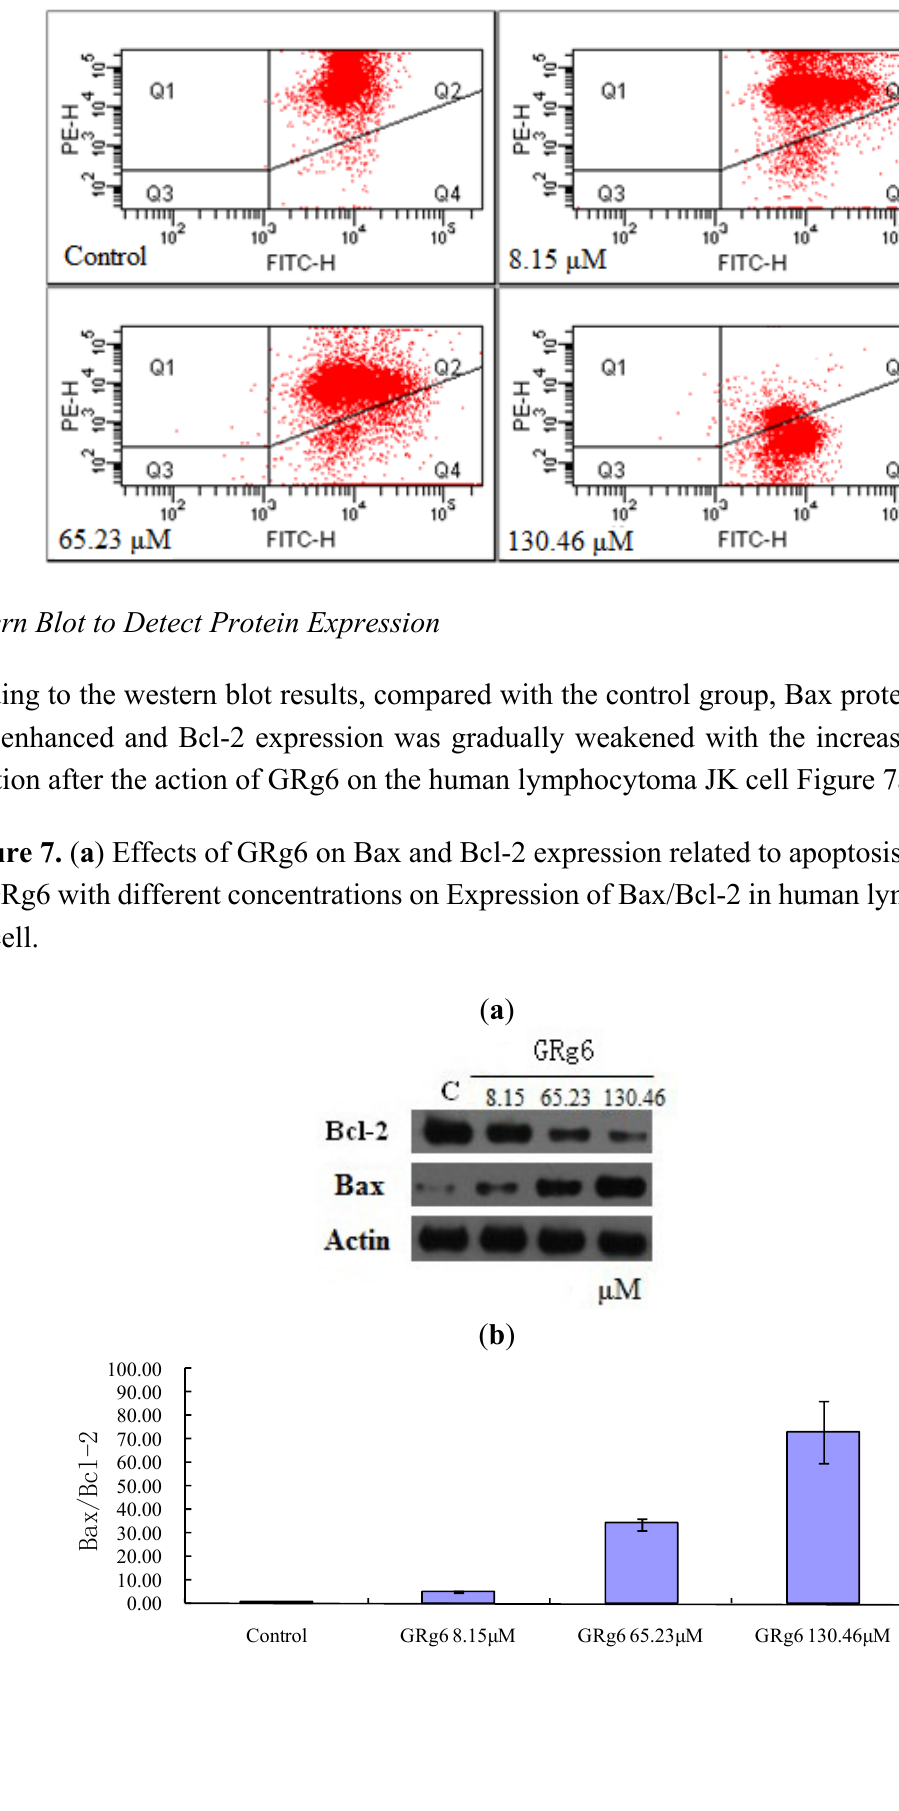
Figure 6. Measurement of mitochondrial membrane potential by JC-1